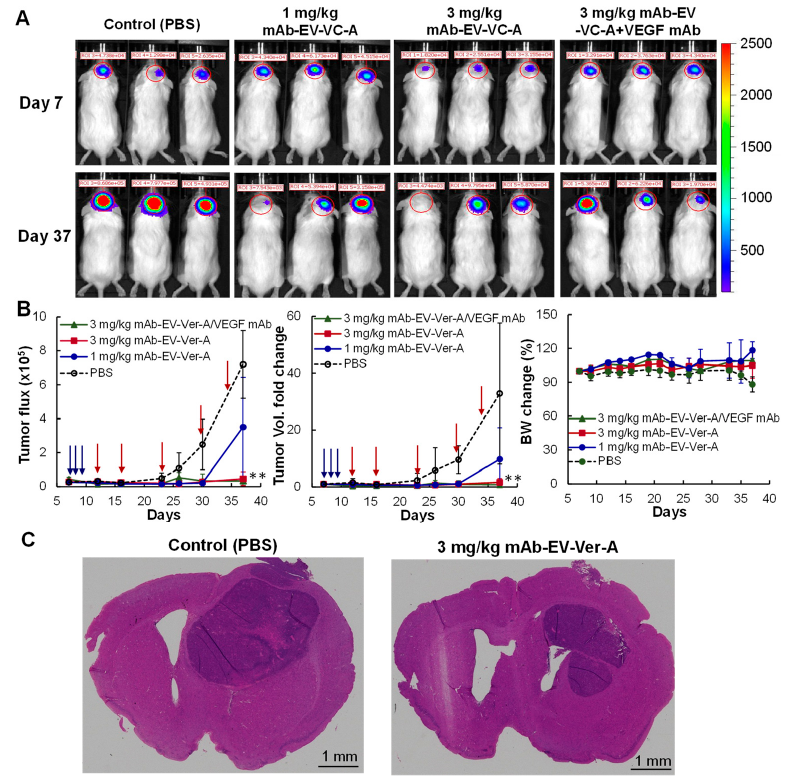
Figure 6. In vivo evaluation of the anti-GBM efficacy of mAb-EV-Ver-A. All mice were treated with 1 mg/kg TMZ daily on days 7–12. The blue arrows indicated the i.p. administration of TMZ. ( A ) Representative IVIS images of GBM intracranial xenograft mice treated with EGFR mAb-EV-Ver-A on days 12, 16, 23, 30, and 34. The red arrows indicated the i.v. administration of mAb-EV-Ver-A. ( B ) Tumor flux, volume fold change, and body weight profiles. Tumor growth was monitored by measuring the FLuc bioluminescence using IVIS, and body weight was measured every 3–4 days. ○ : PBS (control); ● : 1.0 mg/kg mAb-EV-Ver-A; ■ : 3.0 mg/kg mAb-EV-Ver-A; and ▲ : 3.0 mg/kg mAb- EV-Ver-A in combination with VEGF mAb injection on Q3/7Dx7. ** p < 0.005 vs. control using ANOVA followed by Dunnett’s t -test. Data represent mean ± SEM, n = 5. ( C ) Representative H&E staining of brain tissue section. Scale bar: 1 mm.